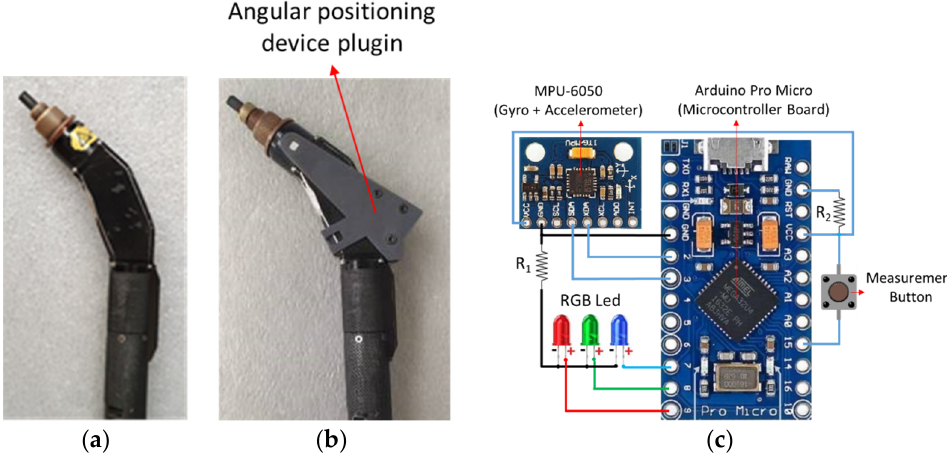
Figure 1. ( a ) Standard hand laser welding torch. ( b ) Smart hand torch with angular positioning assistant device. ( c ) Circuit diagram of angular positioning assist device.